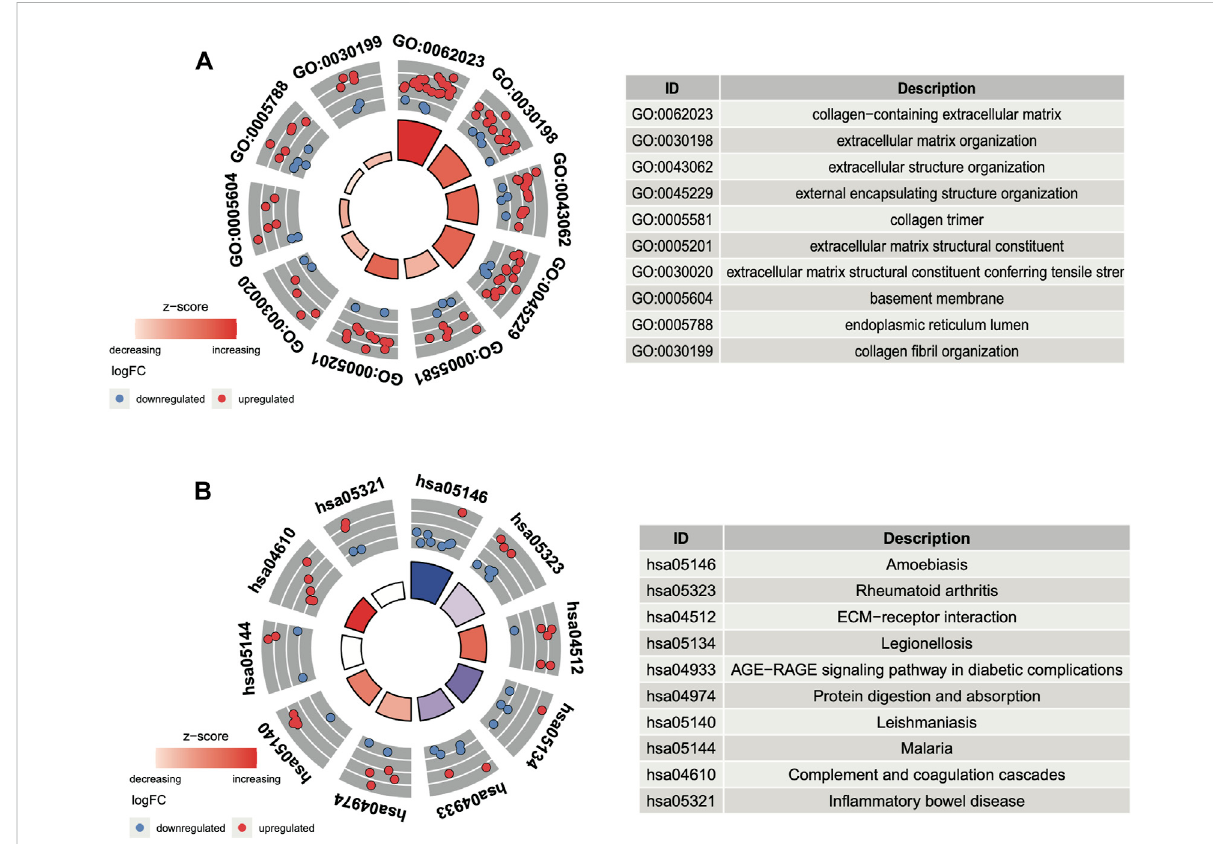
FIGURE 3 Functional analysis of DEGs. (A) Top 10 GO terms ranked by the p -value. (B) Top 10 KEGG pathways ranked by the p